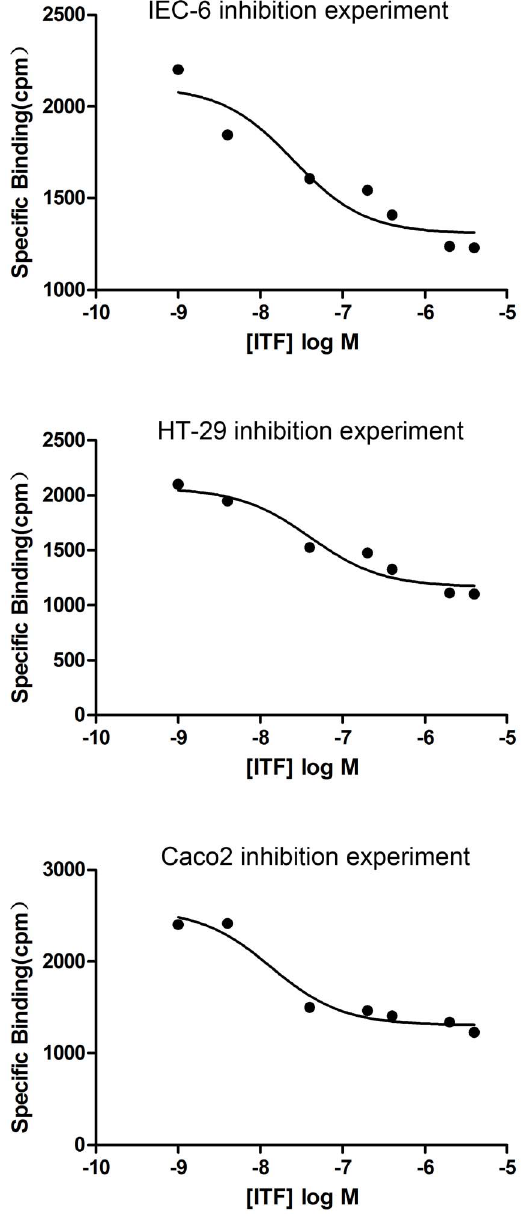
Figure 2. Competition experiment with unlabeled ligand with epithelial cells.